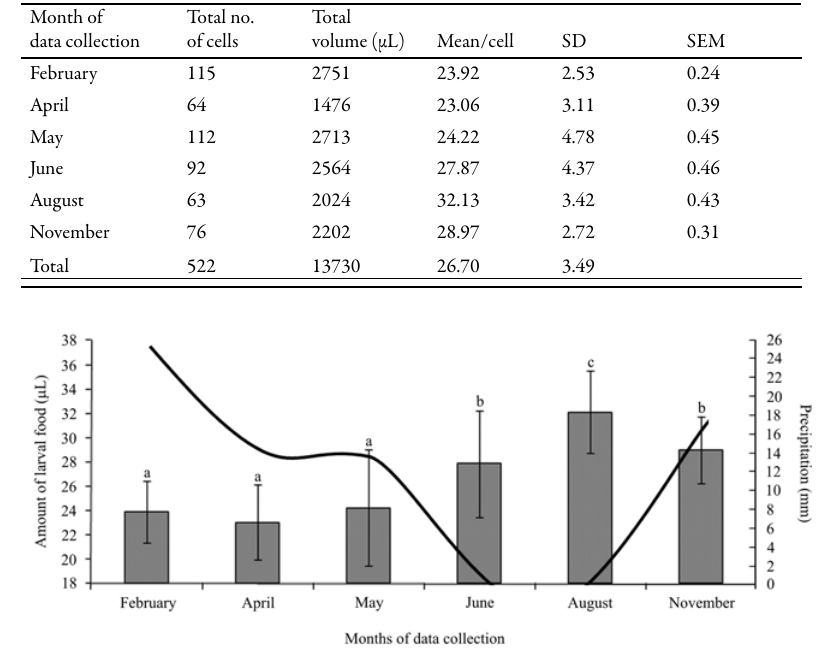
Table 1 : Average amount (μL) of larval food from Frieseomelitta varia deposited in the brood cells during the collection months (2007-2008). SD= Standard Deviation, SEM = Standard Error of the Mean.